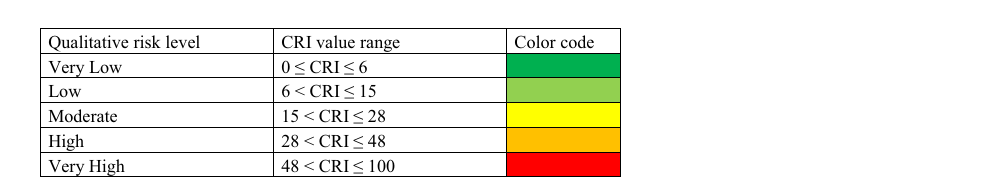
Table 2. Qualitative representation of risk from CRI